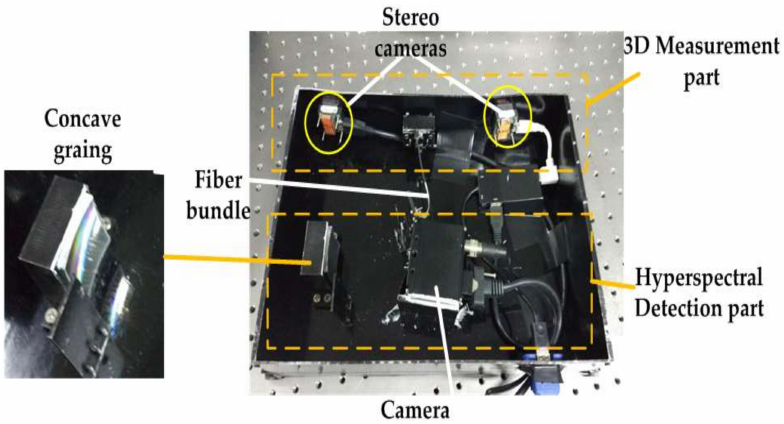
Figure 5. Photograph of the